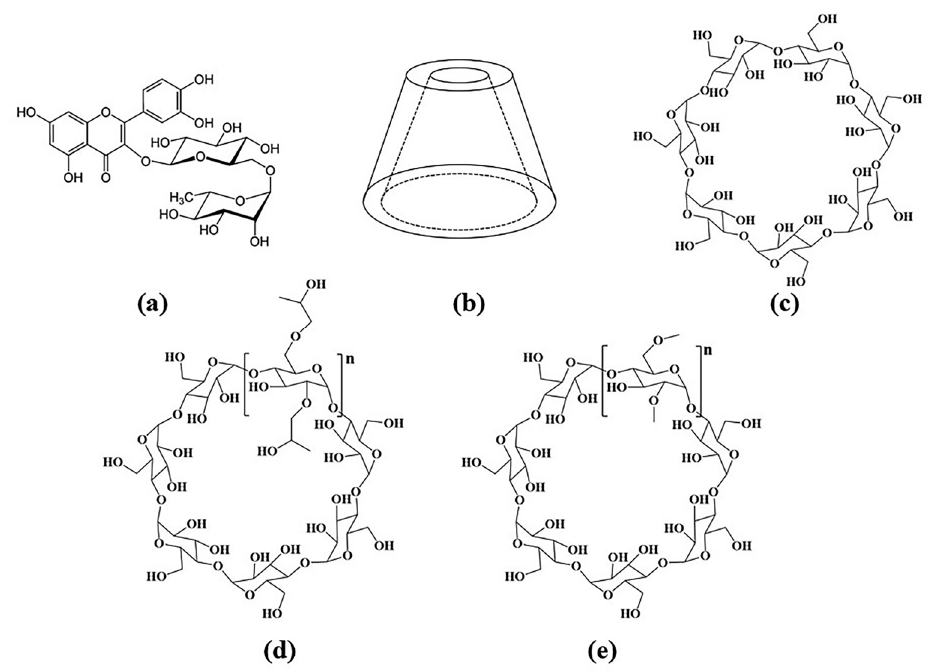
Figure 1. Structural formula of ( a ) rutin, and ( b ) Stereoscopic structure of cyclodextrin, ( c ) β -CD, ( d ) HP- β -CD, and ( e ) DM- β -CD.